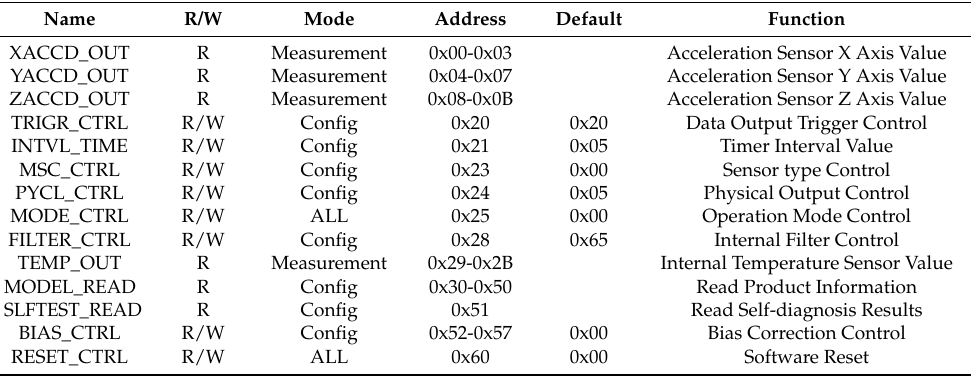
Table 3. Register map of the M-A351AS accelerometer [27].